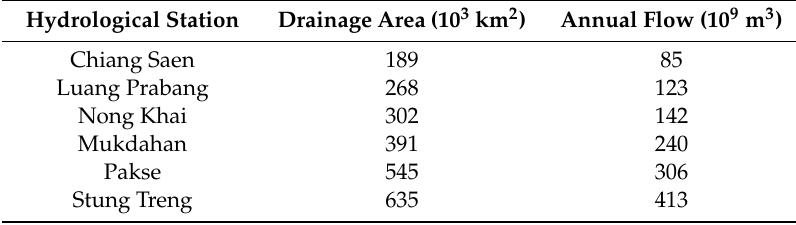
Table 1. Drainage area and annual flow at selected hydrological stations in the Lancang–Mekong River